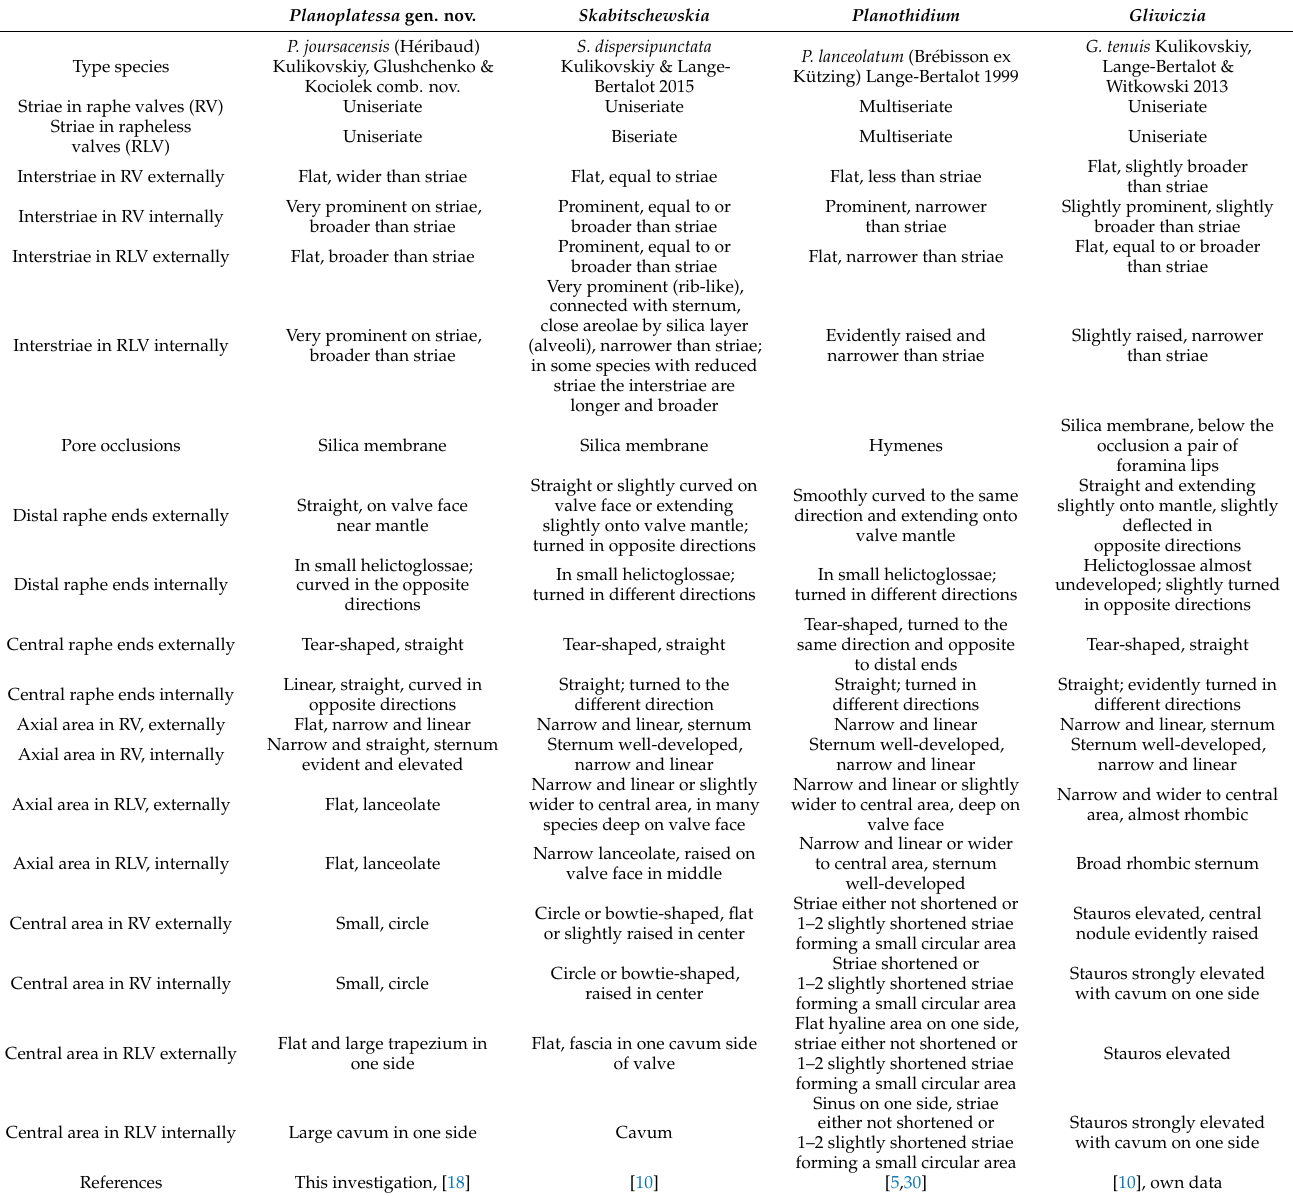
Table 1. Comparison of different freshwater monoraphid diatom genera with cavum. Planoplatessa gen.